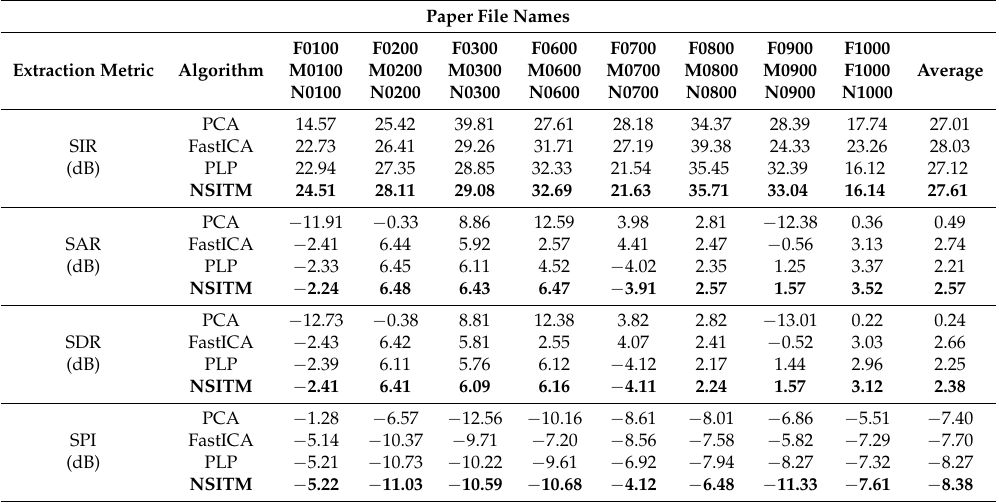
Table 2. Comparison between the FECG extraction performances (SPI, SIR, SAR, and SDR), using the proposed NSITM, PCA, FastICA, and PLP algorithms, considering SNR = 0 dB. Data are collected from Physionet/Fetal ECG Synthetic database (FECGSYNDB).